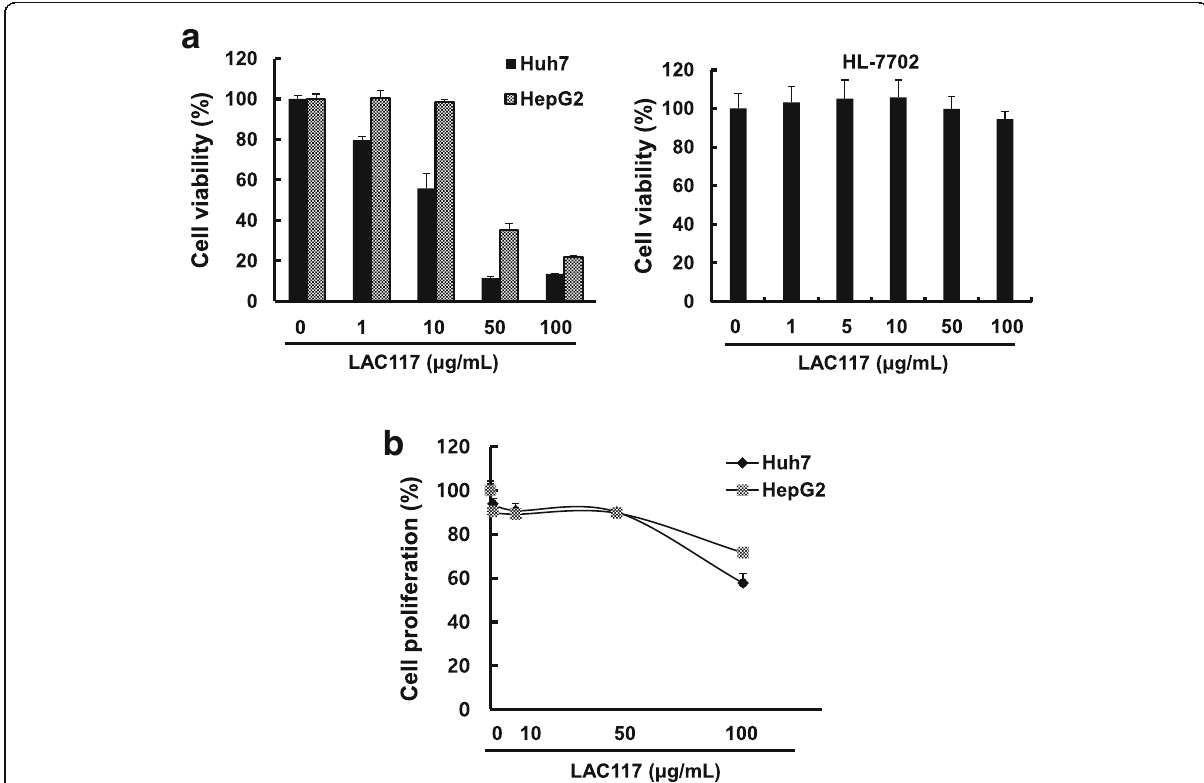
Fig. 2 Effect of LAC117 on the growth and proliferation of HCC cells. a Huh7, HepG2, and HL-7702 cells were treated with LAC117 at the indicated concentration for 72 h, and then MTT assays were performed. b BrdU assay was performed to identify proliferation of HCC cells. Cells were treated with 10, 50, and 100 μ g/mL of LAC117 for 24 h. Data are represented as means ± SEM of